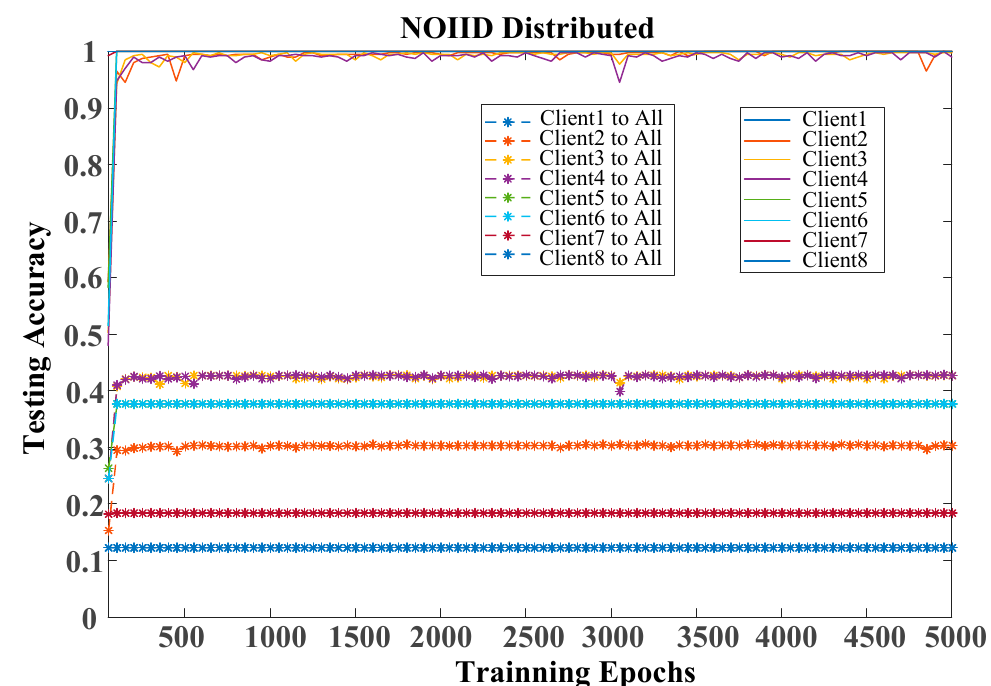
Figure 15. Accuracy rates trend under NOIID data distribution with network parameters isolated.